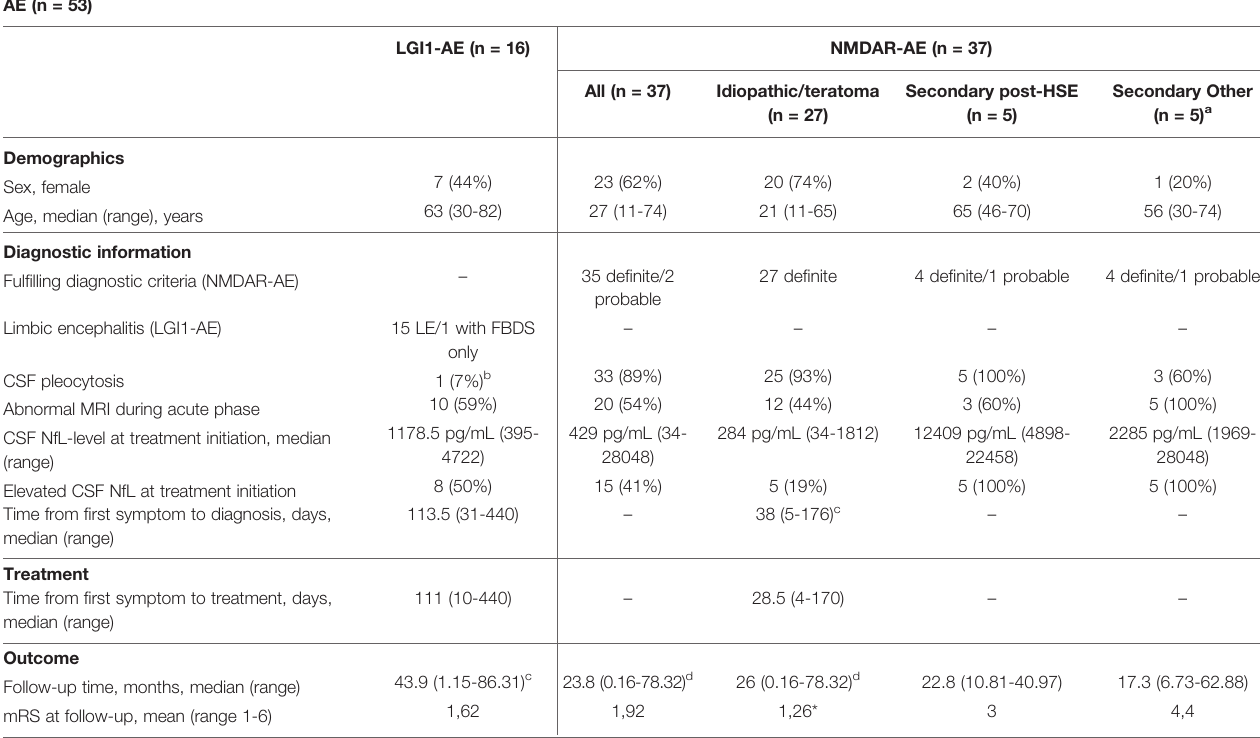
TABLE 1 | Demographics, diagnostic information and outcomes of the AE